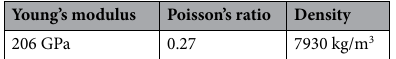
Table 1. Material properties of stainless-steel pipe.